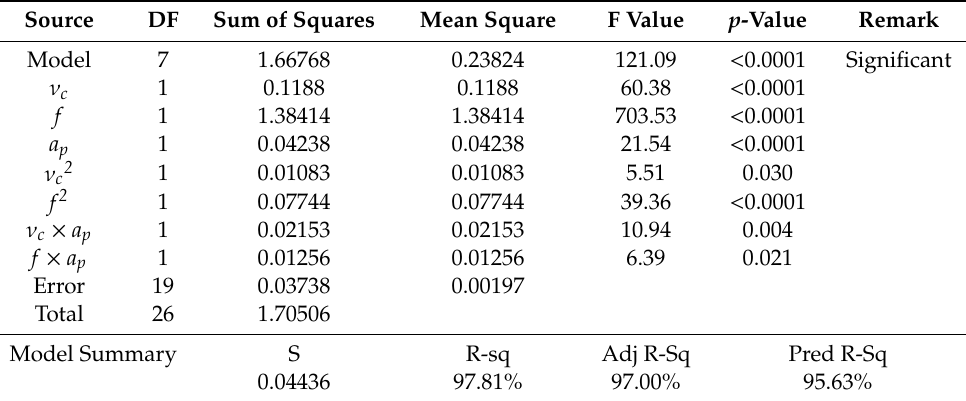
Table 7. ANOVA and R-squared for surface roughness ( Ra ).